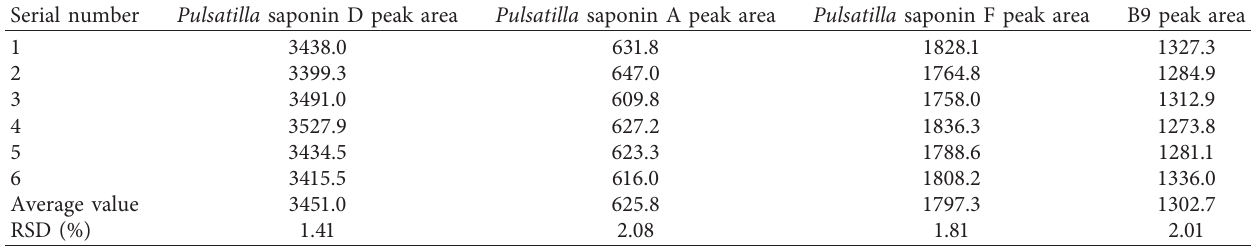
Table 5: The results of repeatability.